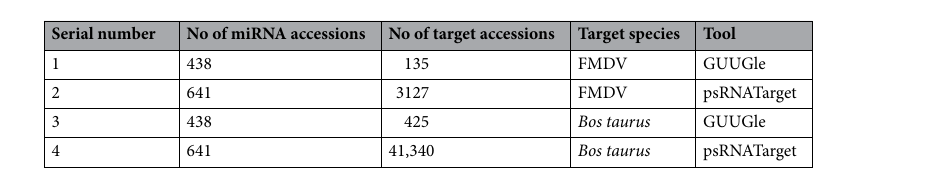
Table 2. Number of targets of miRNAs in FMDV and Bos taurus predicted by GUUGle and psRNATarget.